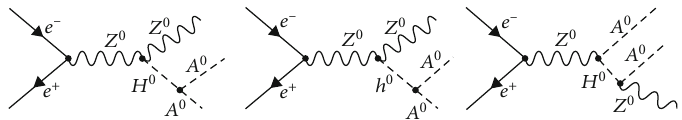
Figure 11: Feynman diagrams contributing to the scattering process e − e + ⟶ ZAA .